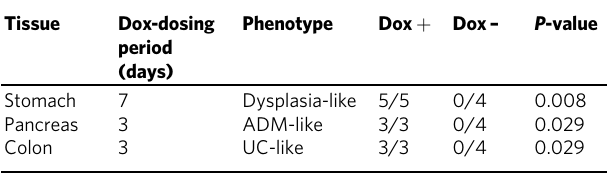
Table 3 Statistic analysis of phenotypes caused in Srf - overexpressing mice